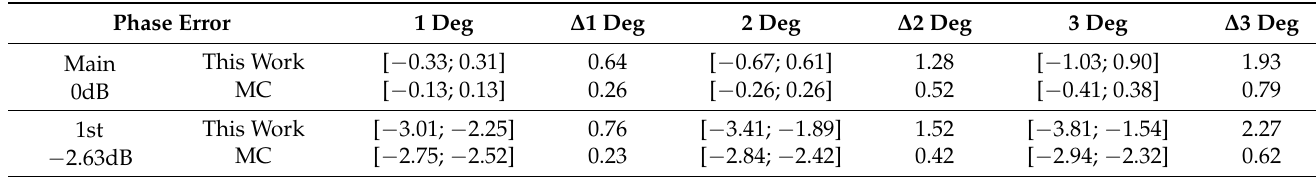
Table 6. Numerical results of SLL of power pattern in Figures 21 and 22.